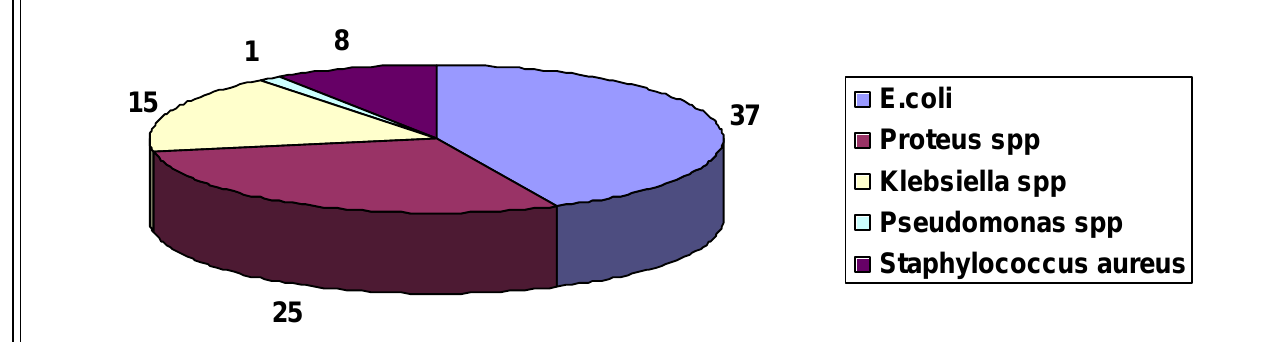
Fig. 1 : Total number of bacteria isolates